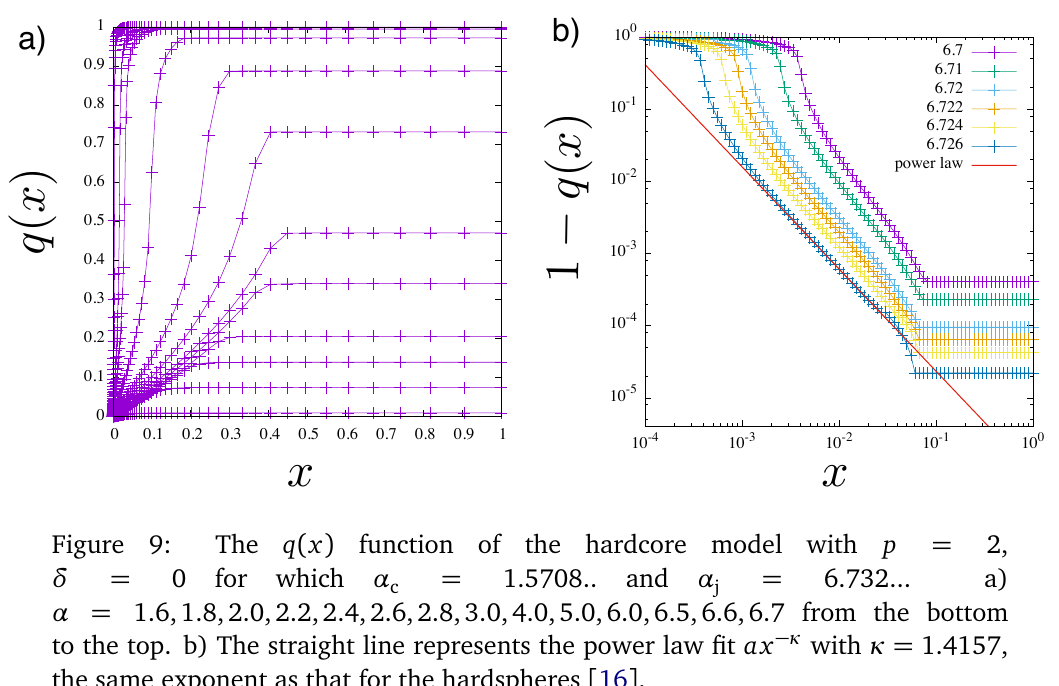
Figure 9: The q ( x ) function of the hardcore model with p = 2, δ = 0 for which α = 1.5708.. and α = 6.732... a) c j α = 1.6,1.8,2.0,2.2,2.4,2.6,2.8,3.0,4.0,5.0,6.0,6.5,6.6,6.7 from the bottom to the top. b) The straight line represents the power law fit ax − κ with κ = 1.4157, the same exponent as that for the hardspheres [ 16 ]